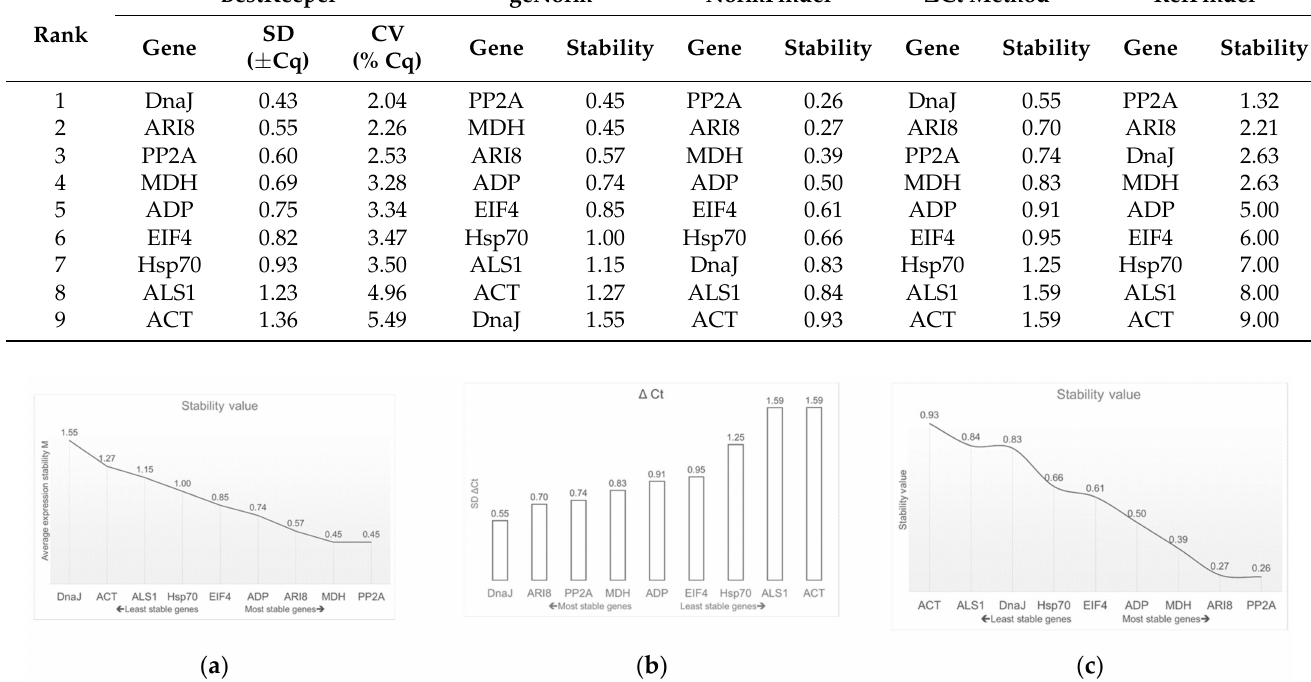
Figure 4. Values of gene expression stability of the nine candidate genes. ( a ) geNorm expression and stability ranking. ( b ) ∆ Ct method values and ( c ) NormFinder expression and stability